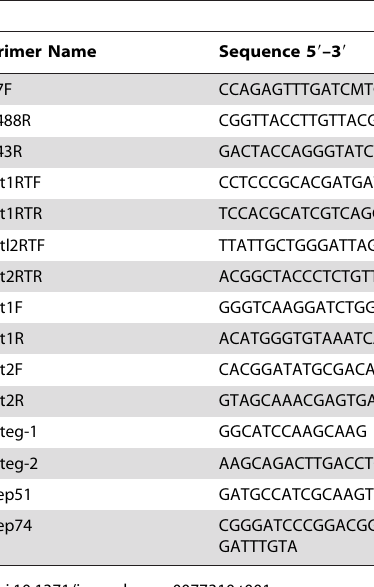
Table 1. PCR-primers used in the present